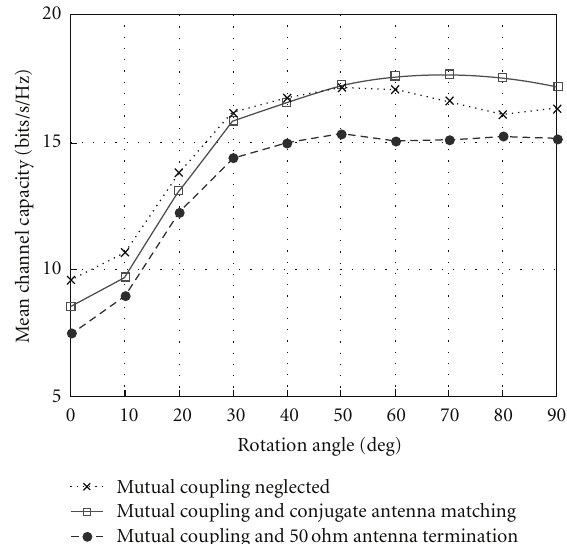
Figure 15: Channel capacity of a 3 × 3 MIMO antenna system, in case of neglected antenna coupling, mutual coupling with and without conjugate matching.